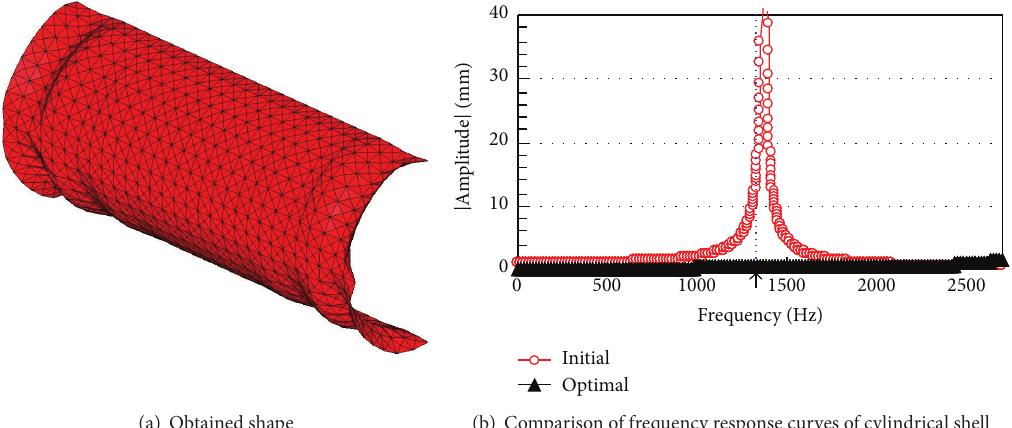
Figure 7: Optimization results for 𝑢 = 0.01 max (𝑢 init ) of half-cylindrical